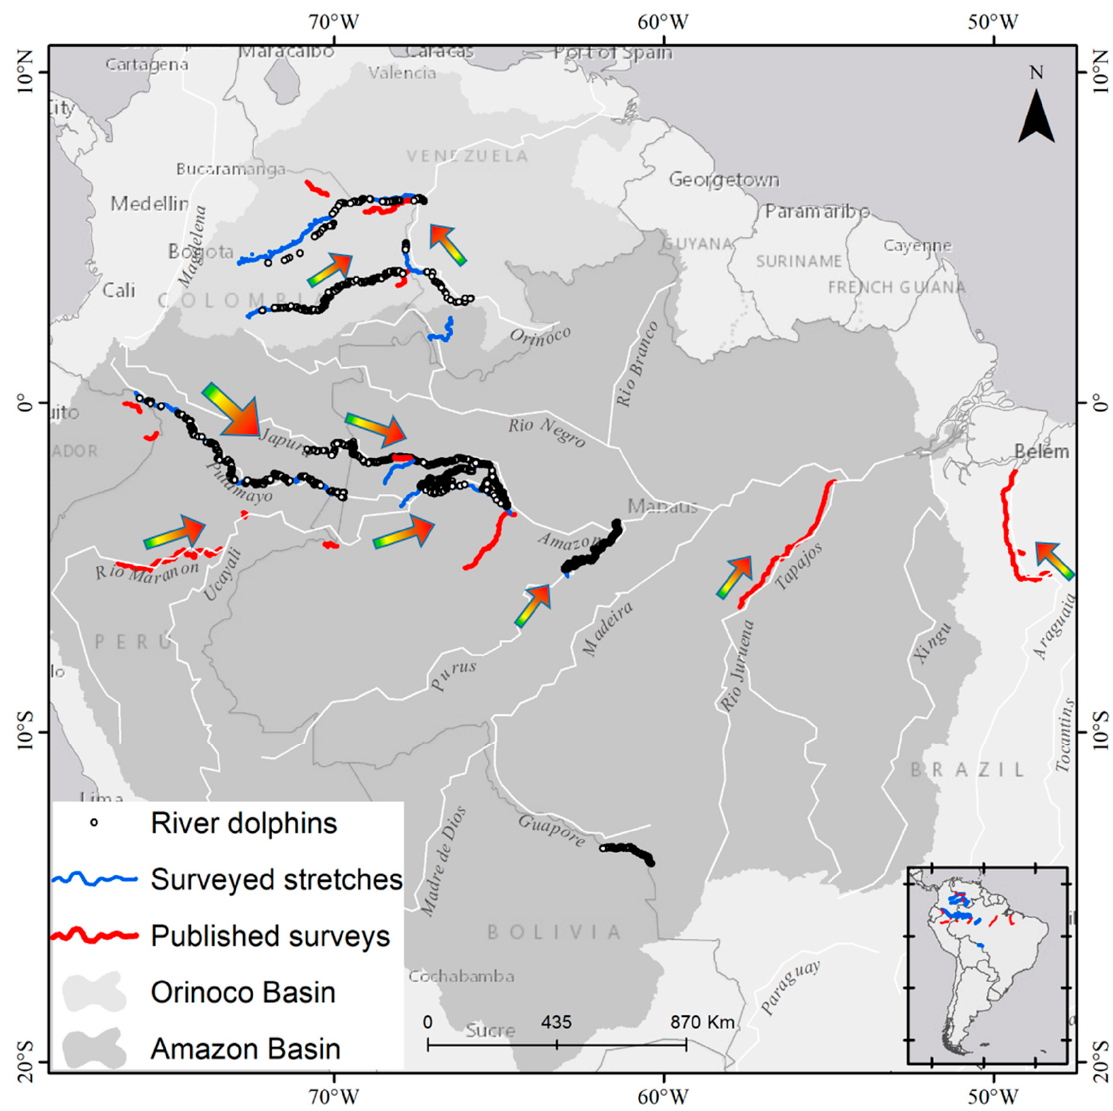
Figure 2. Flow–ecology relationship scheme of densities and abundance of river dolphins through rivers and river basins. Arrow gradient goes from green (lower density/abundance) to red (higher density/abundance).